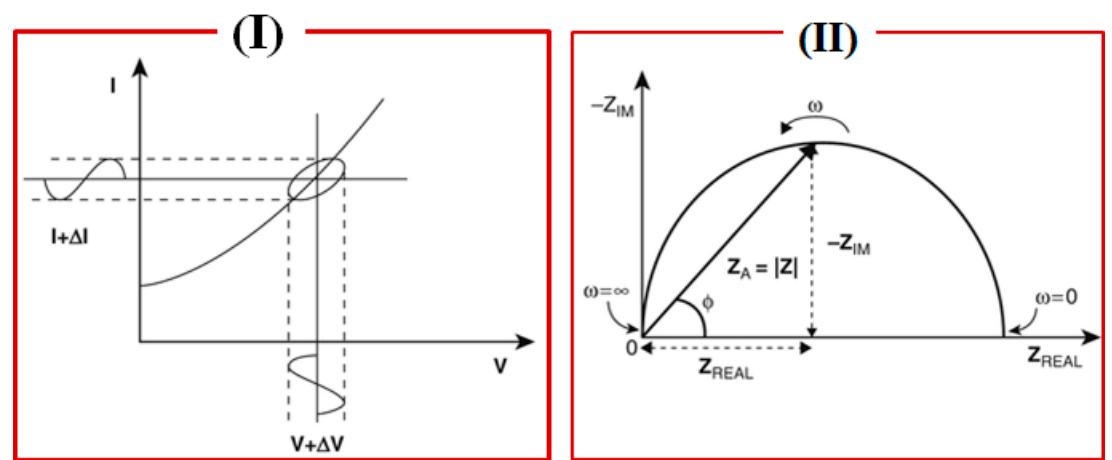
Figure 2. The Lissajous plot ( I ) and the Nyquist plot with impedance vector ( II ). Source: Figure modified from [8], electrochemical impedance spectroscopy (EIS) applications to sensors and diagnostics.